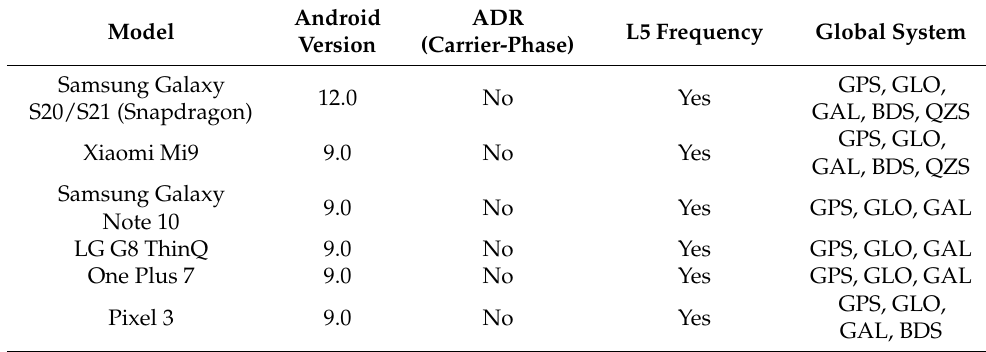
Table 3. Android devices that support raw GNSS measurements (Android Developers